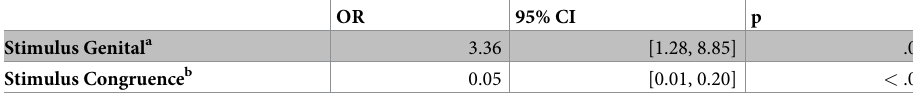
Table 2. Influences on the gender attribution in line with the genital.